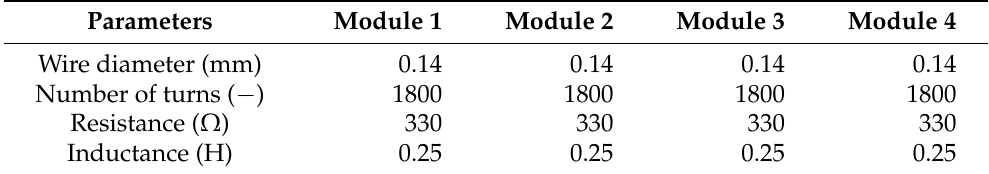
Table 1. Modular coil